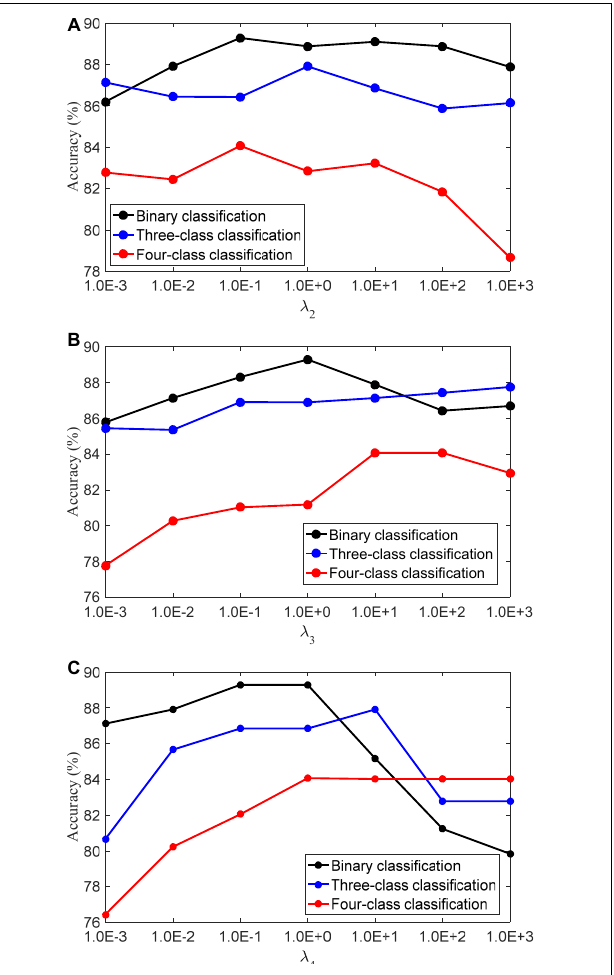
FIGURE 4 | Classification accuracy of LMLS-SRC with different regularization parameters, (A) λ 2 , (B) λ 3 , and (C) λ 4